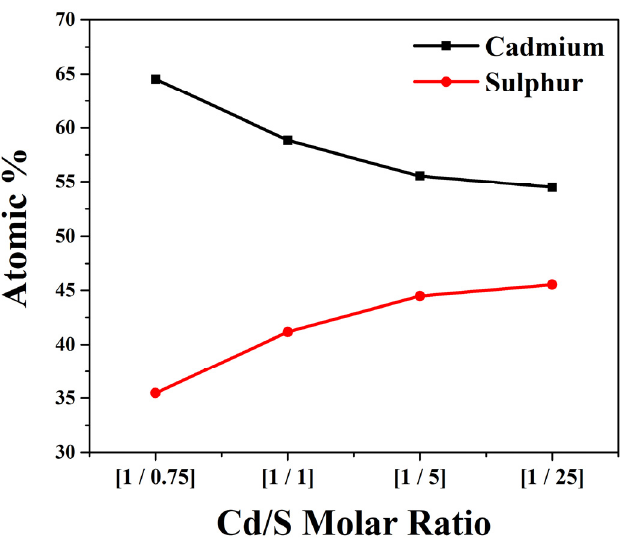
Figure 9. Atomic % of cadmium and sulphur for different [Cd/S] ratio. Figure 9. Atomic% of cadmium and sulphur for different [Cd/S]